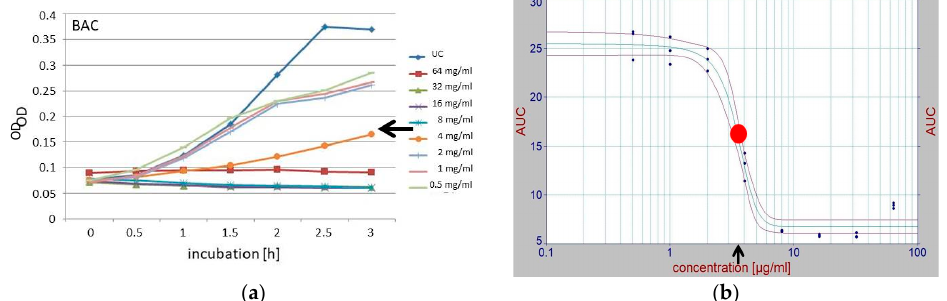
Figure 1. Determination of sublethal concentrations of the single compounds used for further combination experiments, as derived using the classical empirical method ( a ) and the newly introduced area under the curve (AUC) method ( b ), shown with the example of BAC. Various concentrations, from 0 to 128 mg/µL, were used to generate growth curves (as determined by optical density (OD) readings) during the 3 h of incubation, and were plotted in different colors ( a ). The area under the curve (AUC) values from each curve, representing the different concentrations of the applied antibacterial compound of panel ( a ), were calculated, visualized, and plotted against the corresponding concentrations, then fitted 2-dimensionally (TableCurve 2D); then, the inflection point (red dot) was derived ( b ) by applying the default modes of the utilized software. The concentration component of the inflection point was chosen as the sublethal concentration ( b ). Here, the sublethal concentrations derived empirically and by using the AUC method were 4 and 2.5 µ g/mL (black arrows), respectively.